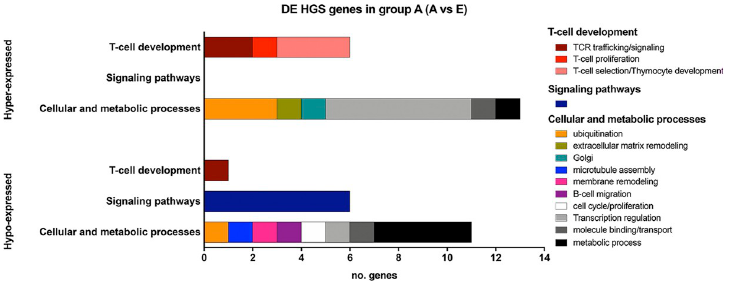
Fig 4. Functional category classification for hyper- or hypo-expressed DE HGS genes in the group A (group A vs group E). Biological functions were assigned to the 37 DE HGS genes distributed in the three age-related modules: tan, green yellow, and